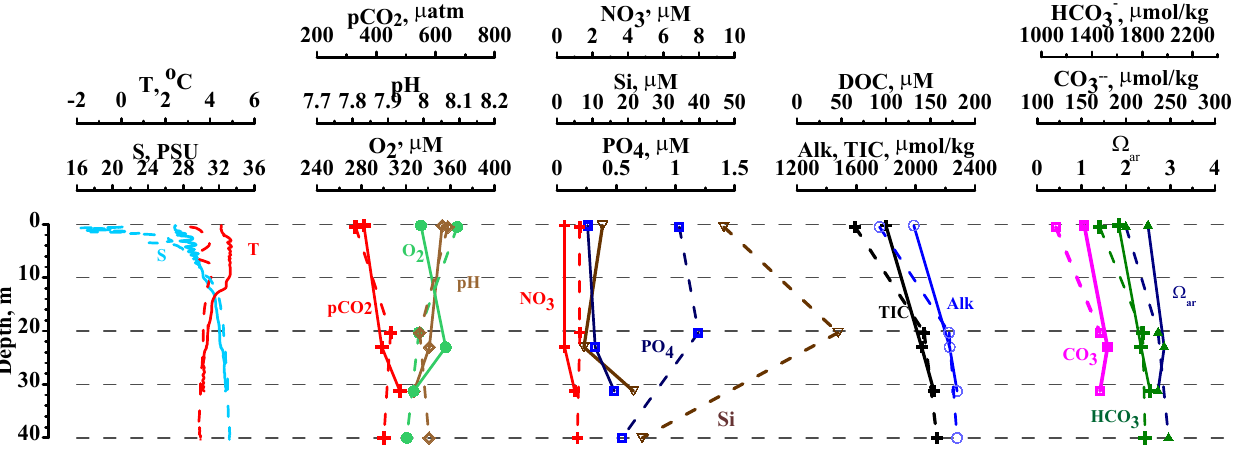
Figure 5. Vertical distribution of physical and chemical parameters at stations TS1 near the glacier (dotted line) and TS2 in the fjord outlet (solid line), sampled on 06/09/2011.